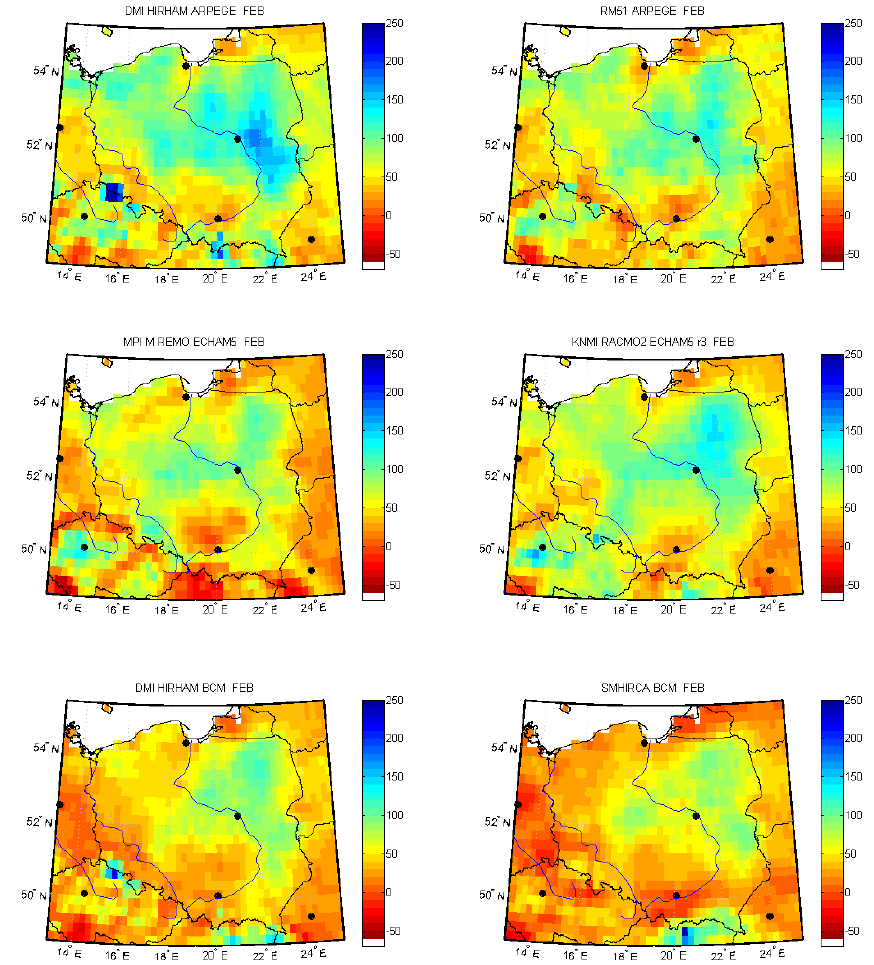
Figure 5. Comparison of spatial patterns of differences in the standard deviation of monthly precipitation for February for uncorrected relative to corrected RCM data for the month of February for the reference period